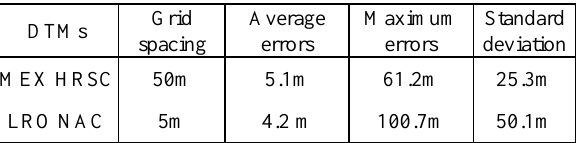
Table 2. The height displacements between the generated DTMs and reference DTMs for the plotted terrain